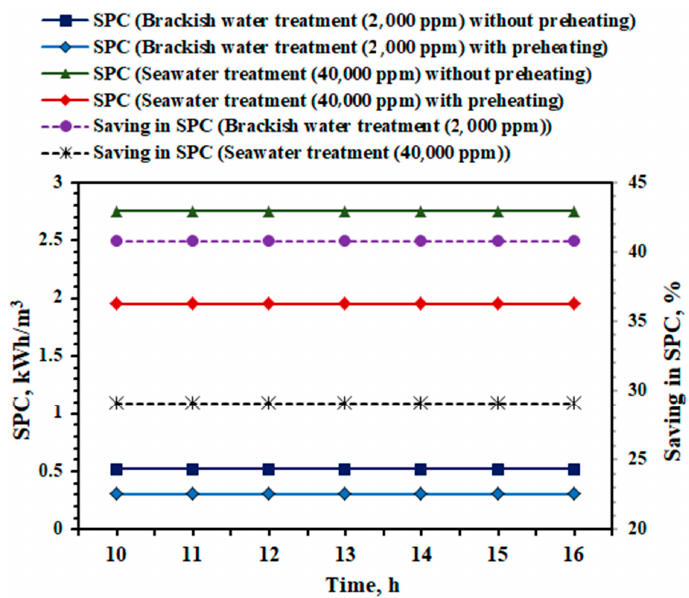
Figure 6. Variation of SPC and saving in SPC.